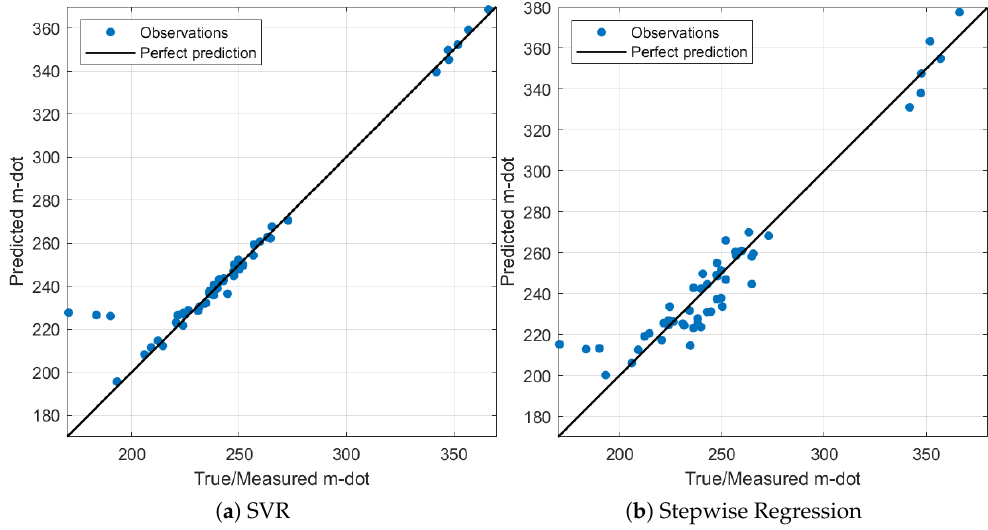
Figure 5. Specific throughput predicted vs. true response plots for the selected models.